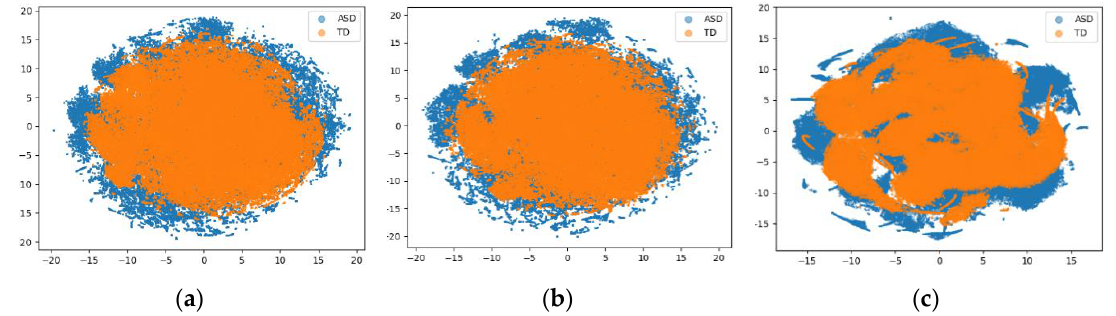
Figure 3. Two-dimensional scatter plot for ( a ) eGeMAPS-88, ( b ) eGeMAPS-54, and ( c ) the AE processed by t-stochastic neighbor embedding (t-SNE).